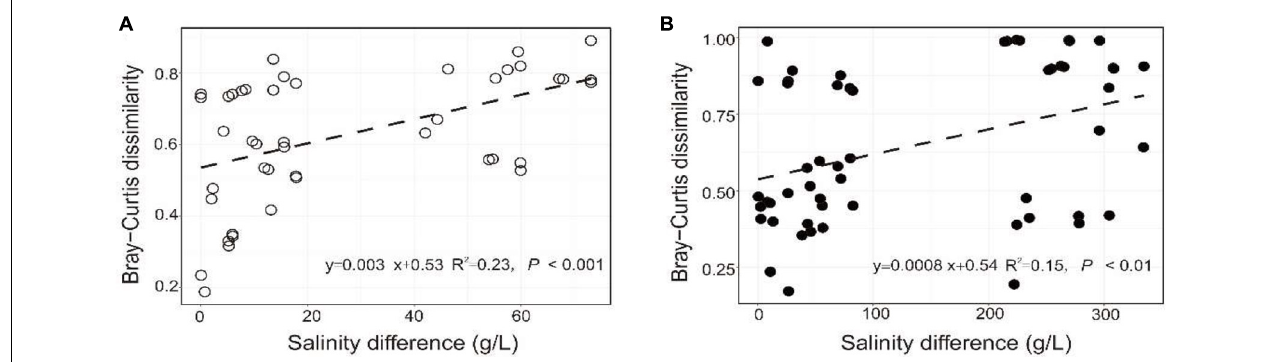
FIGURE 5 | Relationship between the microbial community difference of the experiment 1 (A : simulating salinization) and experiment 2 (B : simulating desalinization) and sedimentary salinity difference.